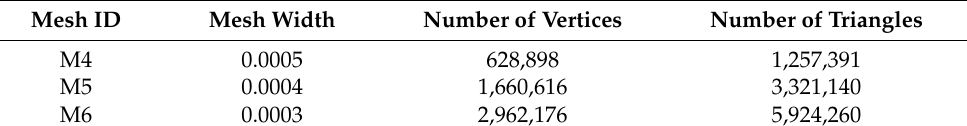
Table 1. Strong scalability measurements: Meshes for the wind turbine blade at varying mesh resolutions (mesh width). The mesh width indicates the average edge length used to construct the surface mesh.